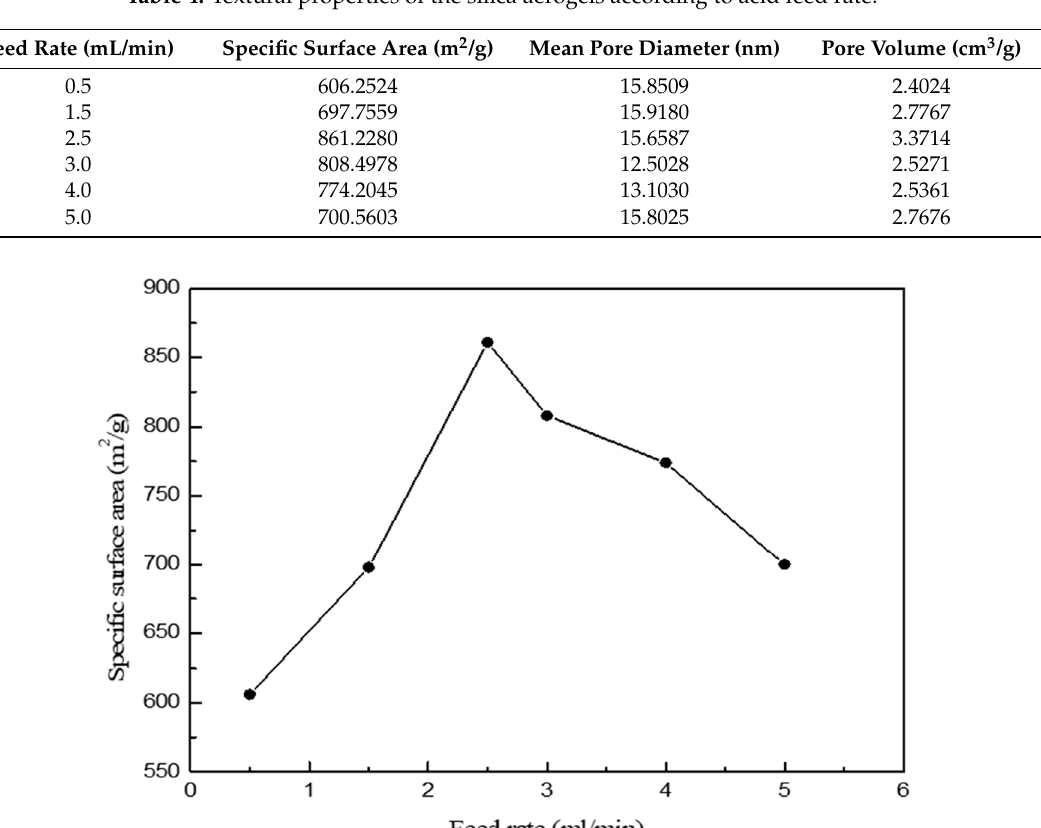
Table 4. Textural properties of the silica aerogels according to acid feed rate.